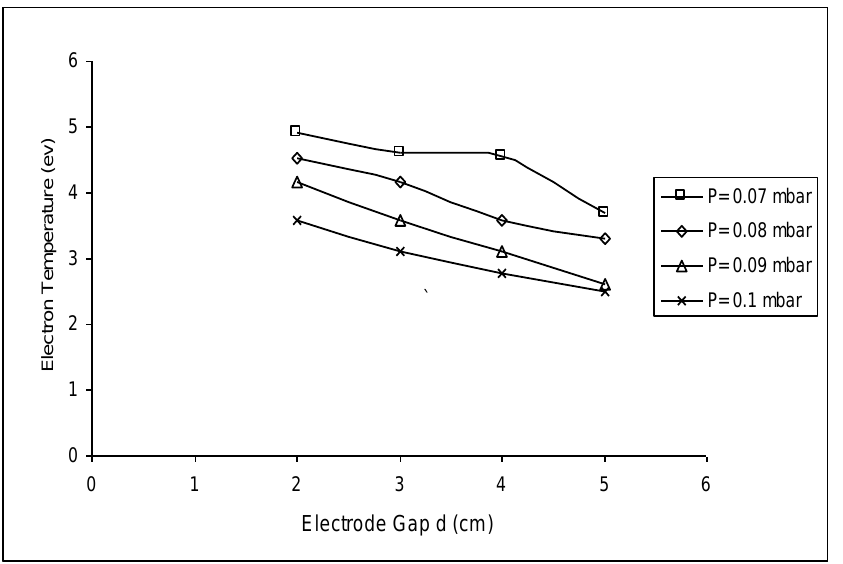
Fig.4: Electron temperatures with electrode gaps at different plasma pressure.